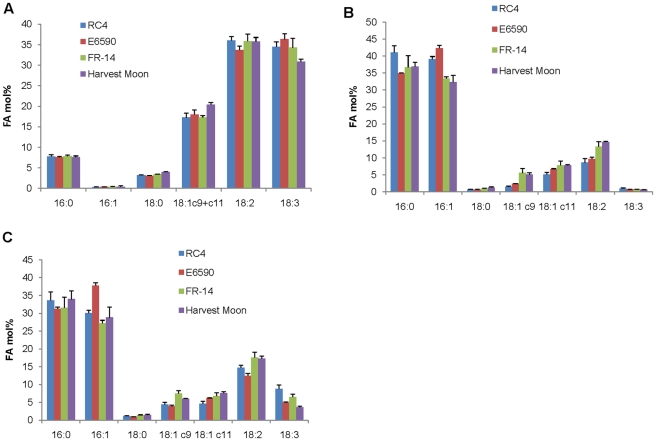
Fatty acid composition of total lipids in A) seed oil, B) pulp oil and C) whole berry oil of four cultivars RC-4, E6590, FR-14 and Harvest Moon.Results represent the mean ± SD of three biological replicates. Minor fatty acids (accounting in total for <3% of the fatty acid composition) are not shown. 16∶0, palmitic acid; 16∶1, palmitoleic acid; 18∶0, stearic acid; 18∶1c9, oleic acid; 18∶1c11, cis-vaccenic acid; 18∶2, linoleic acid; 18∶3, α-linolenic acid.